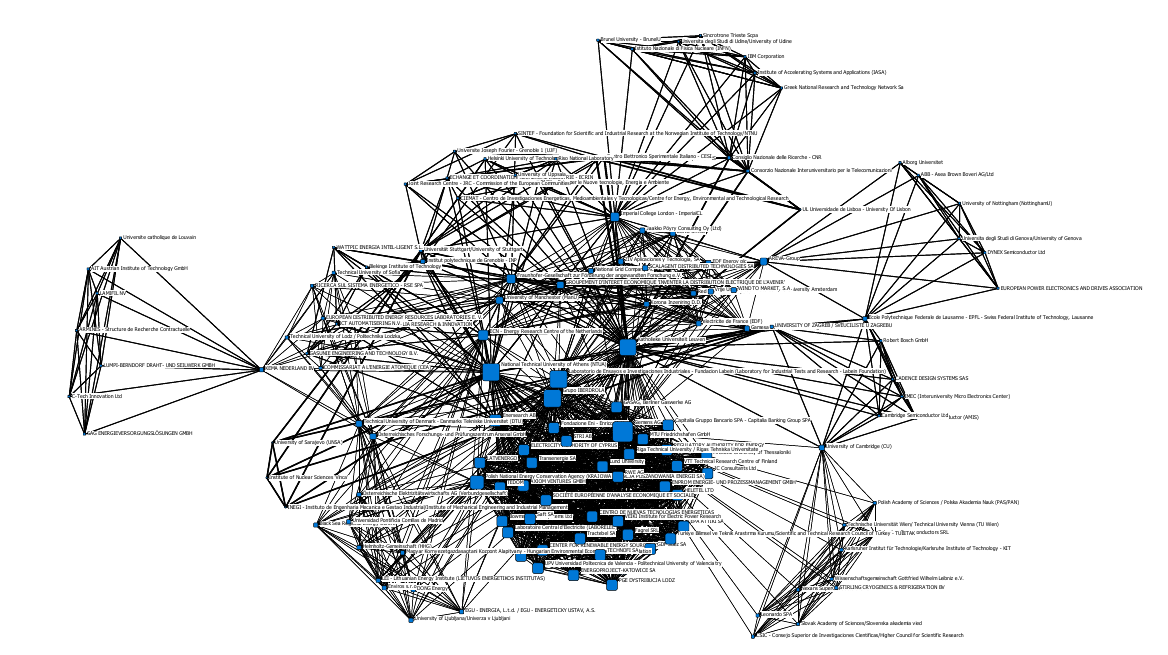
Figure 4. FP6 Generic Grid projects. Social network based on Freeman degree centrality, one sub- network (N = 14